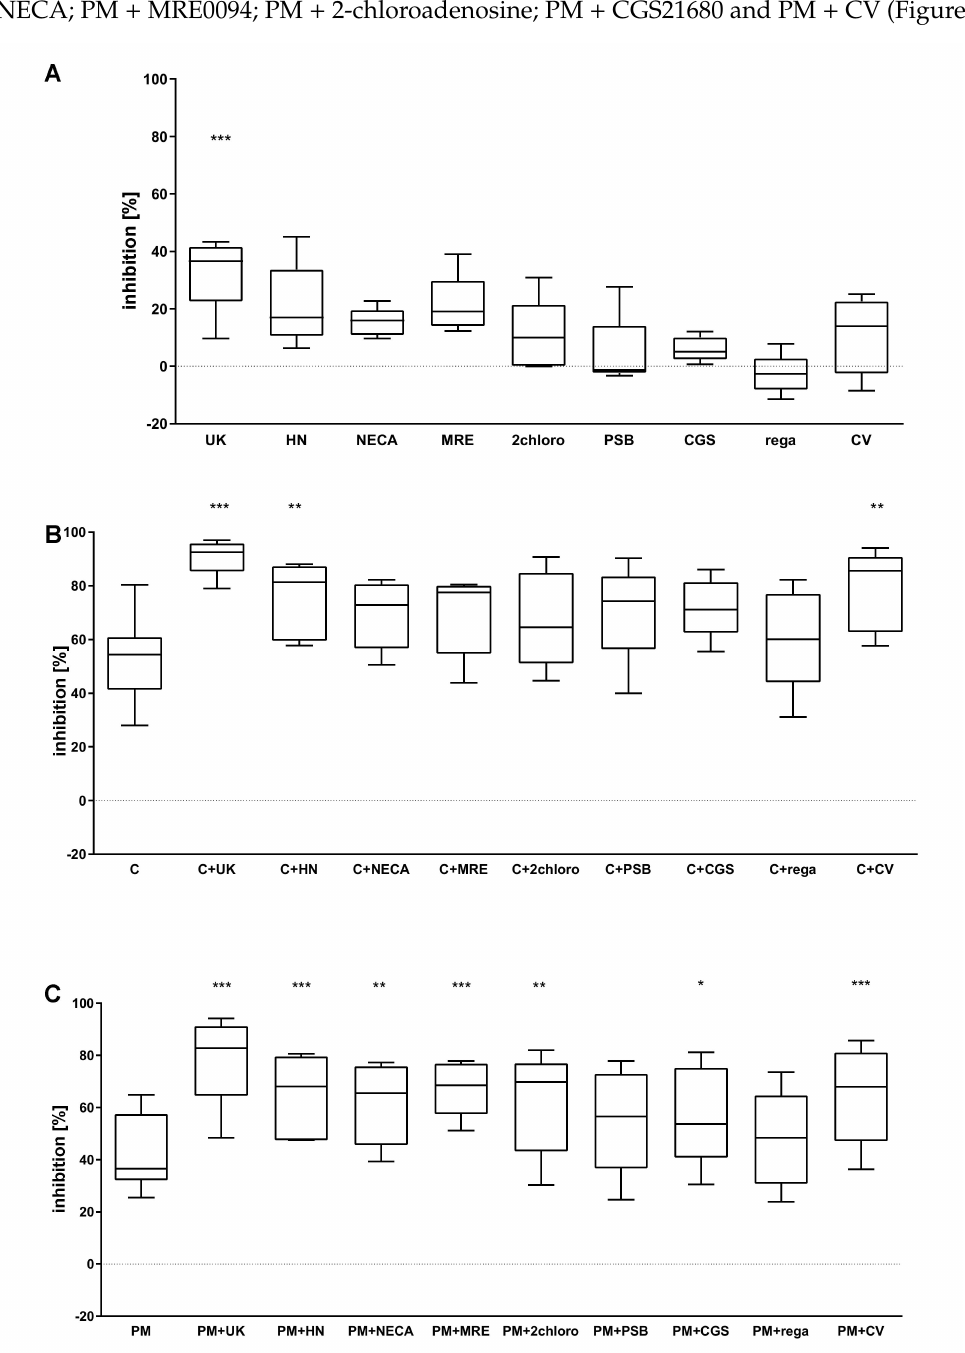
Figure 3. AR agonists intensify the inhibitory e ff ect of P2Y 12 antagonists on platelet reactivity, as measured by expression of GPIIb-IIIa active form (PAC-1 antibody binding) ( n = 5). ( A ) E ff ect of AR agonist on platelets, ( B ) e ff ect on platelets antagonised with the P2Y 12 inhibitor cangrelor, ( C ) e ff ect